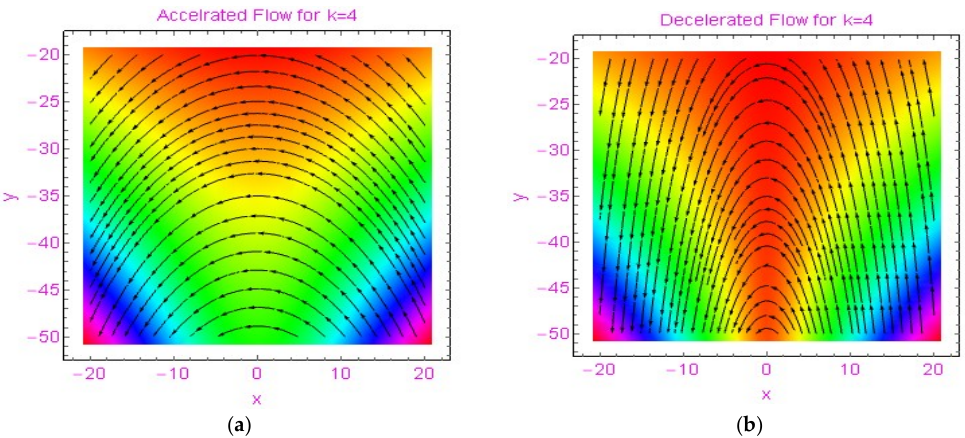
Figure 4. Streamlines behavior for ( a ) accelerated, ( b ) decelerated flow situations when k-4. Energies 2020 , 13 , x FOR PEER REVIEW